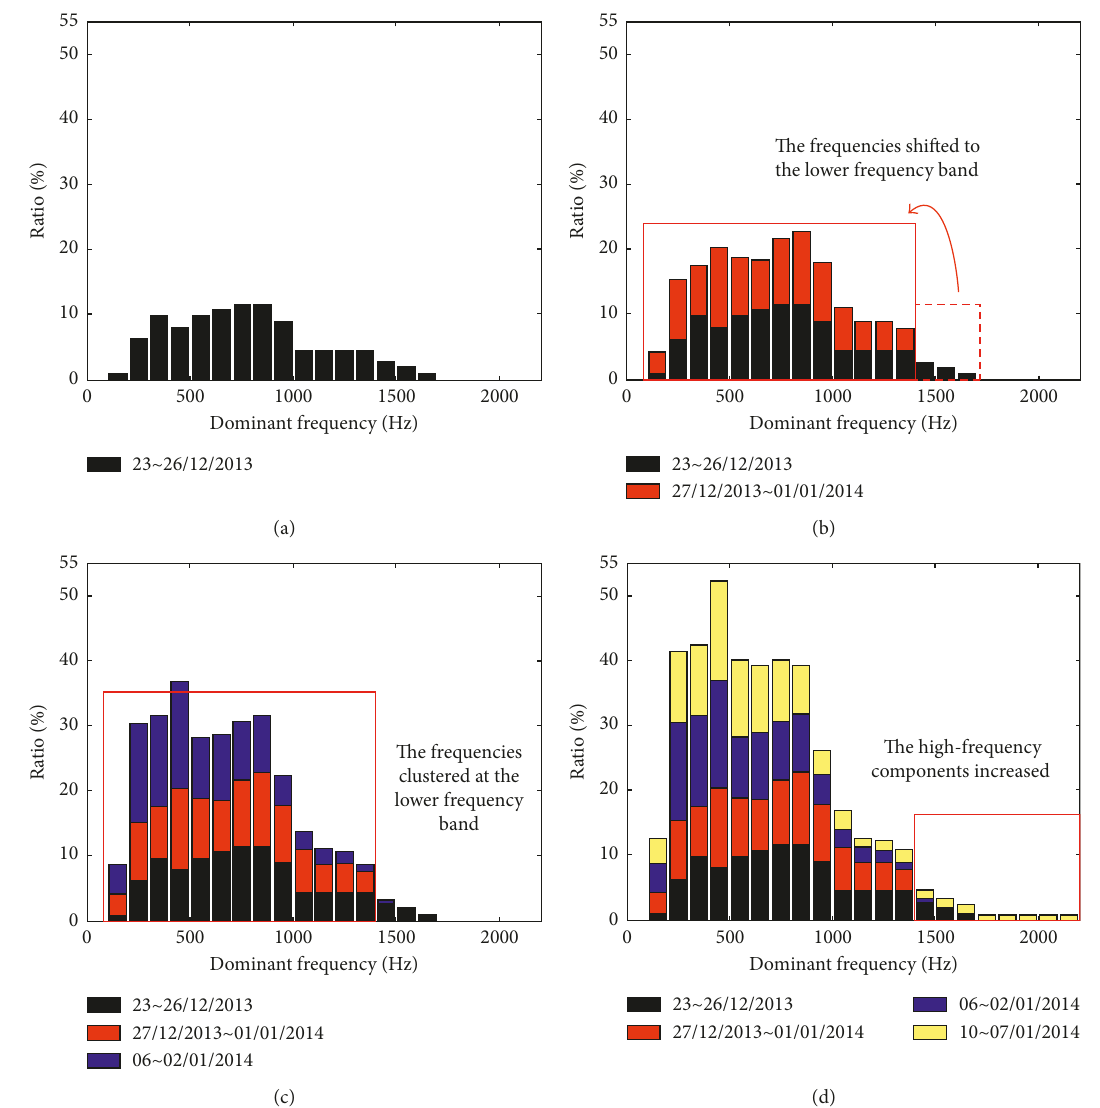
Figure 9: The accumulative variation of dominant frequency of MS signals: (a) date time: 23/12/2013 ∼ 26/12/2013, (b) date time: 23/12/2013 ∼ 1/1/2014, (c) date time: 23/12/2013 ∼ 6/1/2014, and (d) date time: 23/12/2013 ∼